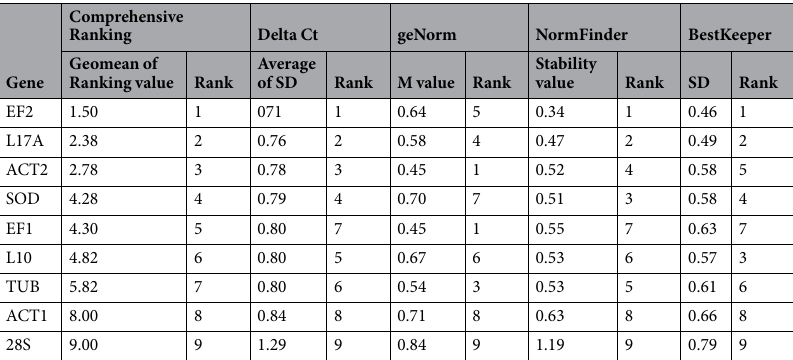
Table 4. Stability of candidate reference genes under ascovirus-infected conditions in IOZCAS-Spex-II-A cells across all